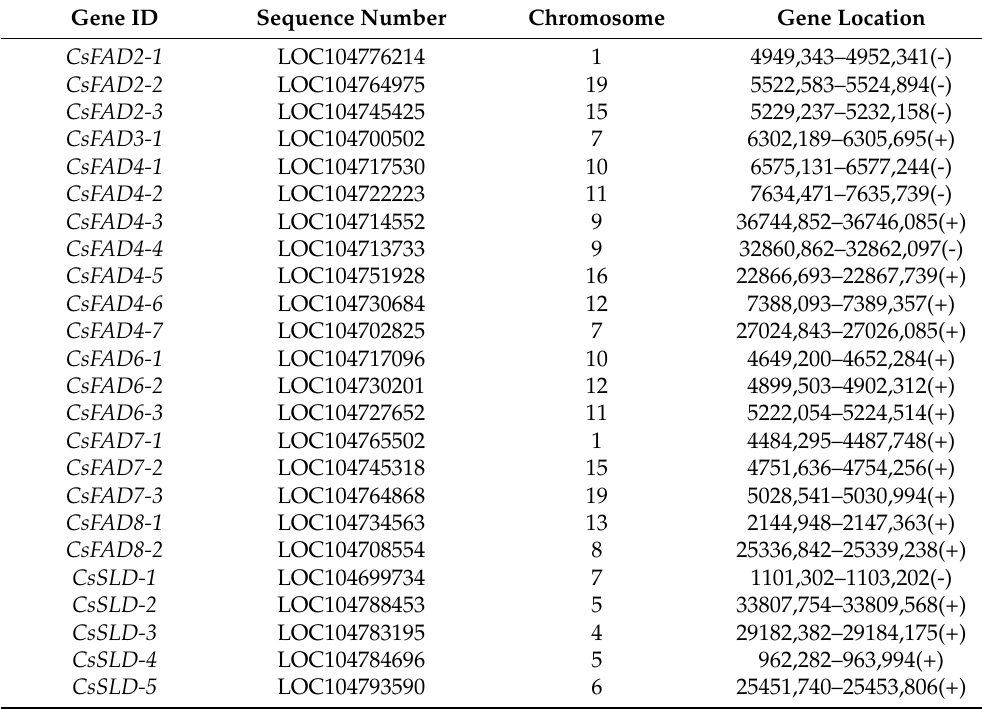
Table 1. Sequence analysis of CsFAD gene